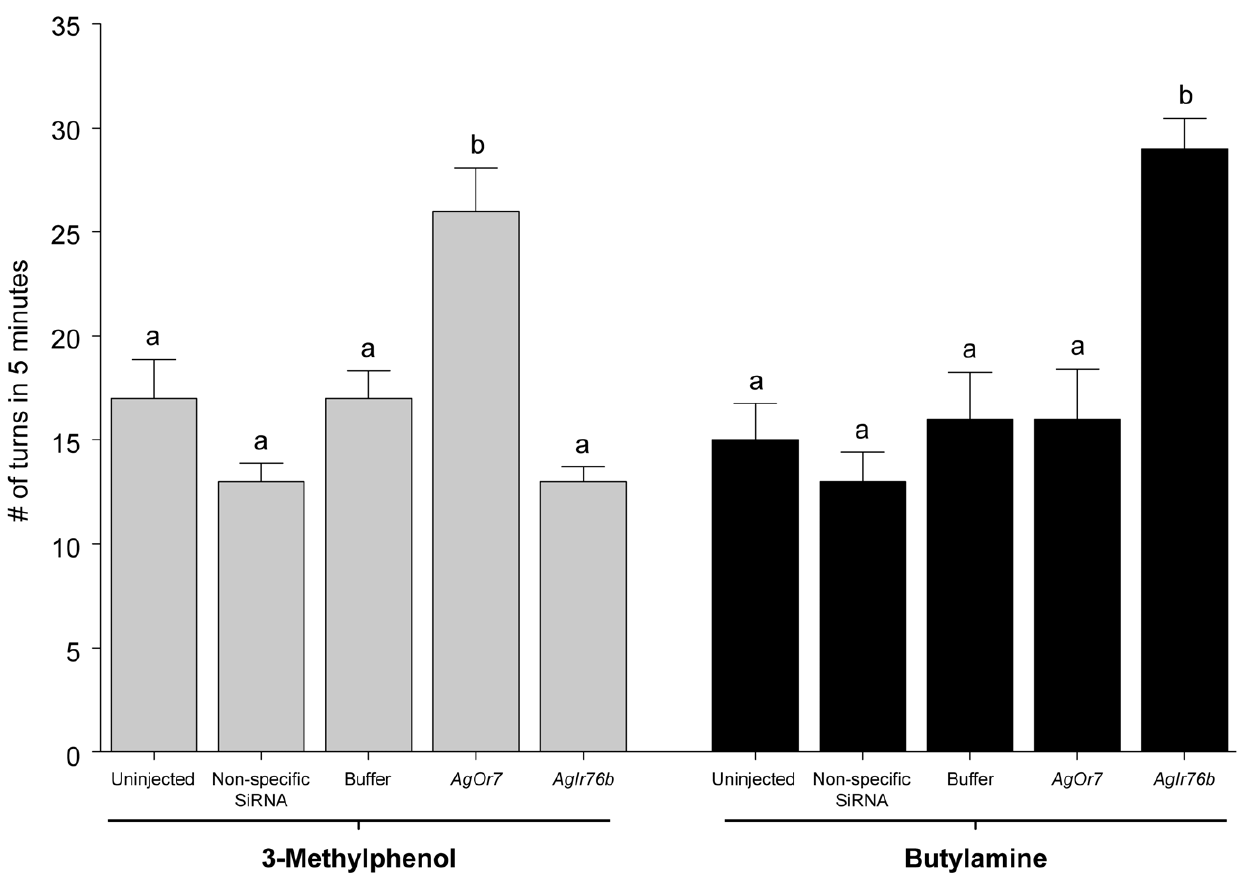
Figure 12. Olfactory responses to 3-methylphenol and butylamine are mediated by distinct signaling pathways. The turning rates exhibited by uninjected larvae as well as those receiving mock (buffer-alone), non-specific, or siRNA injections in response to 10 2 4 v/v dilutions of 3- methylphenol or butylamine were assessed independently over a 5 min time lapse. (A) Larval responses to 3-methylphenol were significantly altered by AgOr7 knockdown but unaffected by AgIr silencing. (B) Conversely, responses to butylamine were sensitive to reduction in AgIr76b mRNA levels but indifferent to silencing of AgOr7 expression.